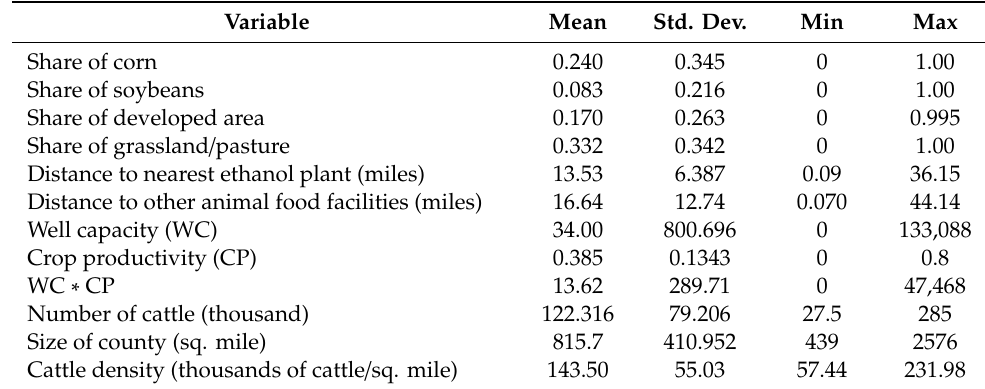
Table 3. Descriptive